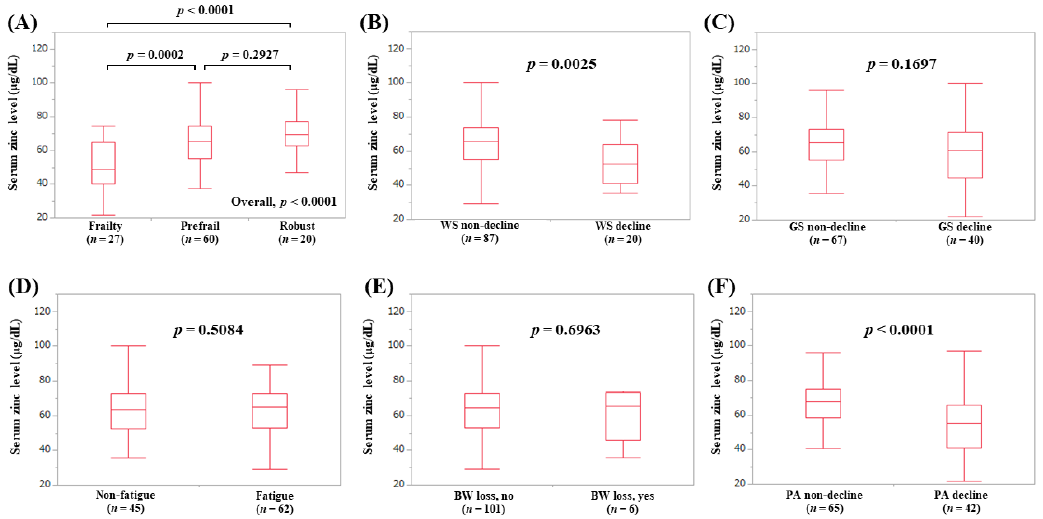
Figure 4. Serum Zn level according to the frailty status ( A ) and serum Zn level according to each frailty phenotype in LC patients: ( B ) walking speed, ( C ) grip strength, ( D ) fatigue, ( E ) body weight